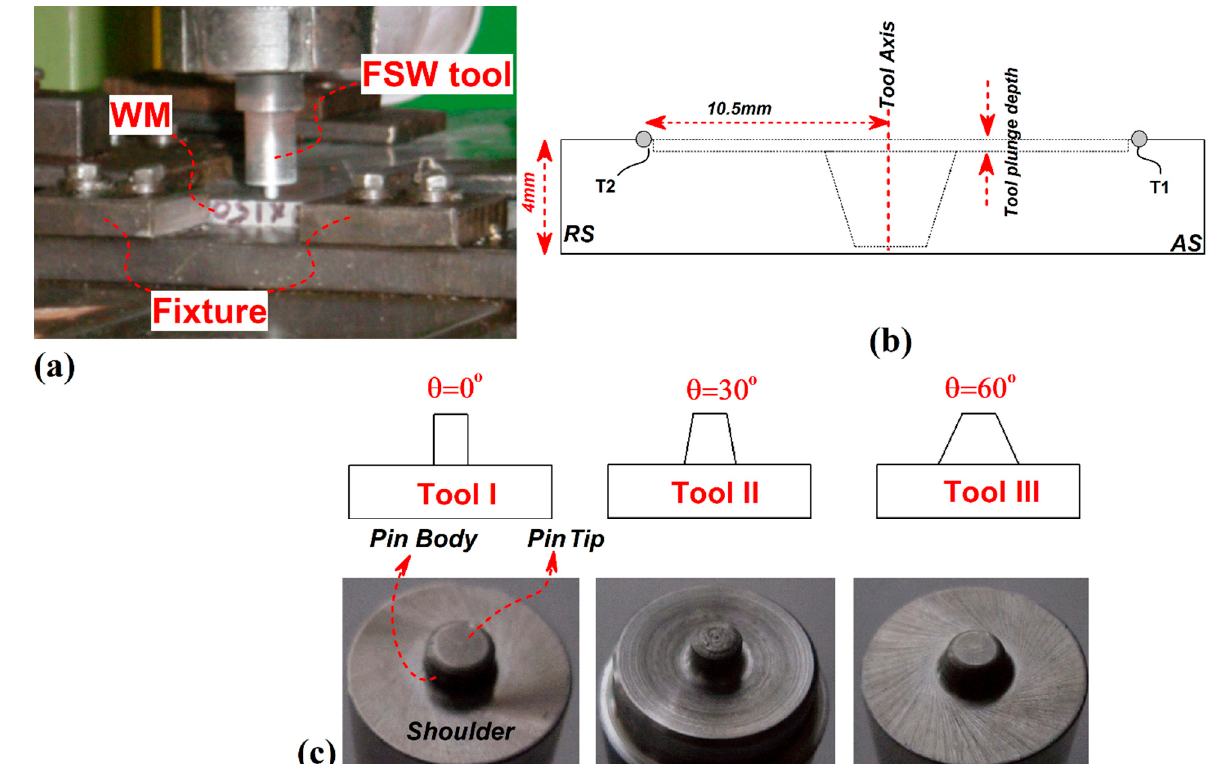
Figure 2. ( a ) used FSW fixture in this study, ( b ) Schematic view of thermocouples place, ( c ) schematic view and image of used tool in this study.